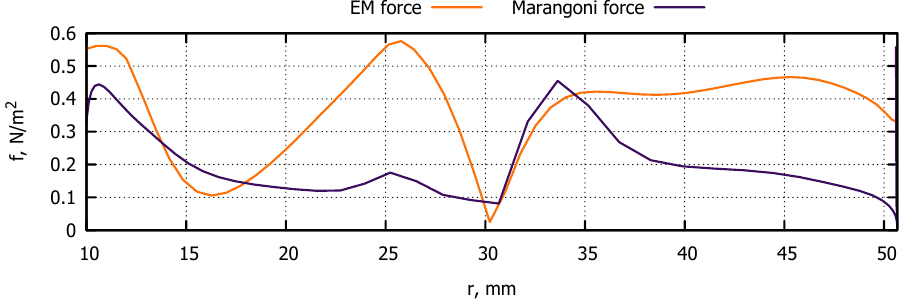
Figure 12. Absolute values of the EM and Marangoni force density on the free melt surface during the cylindrical phase ( D C = 102mm).